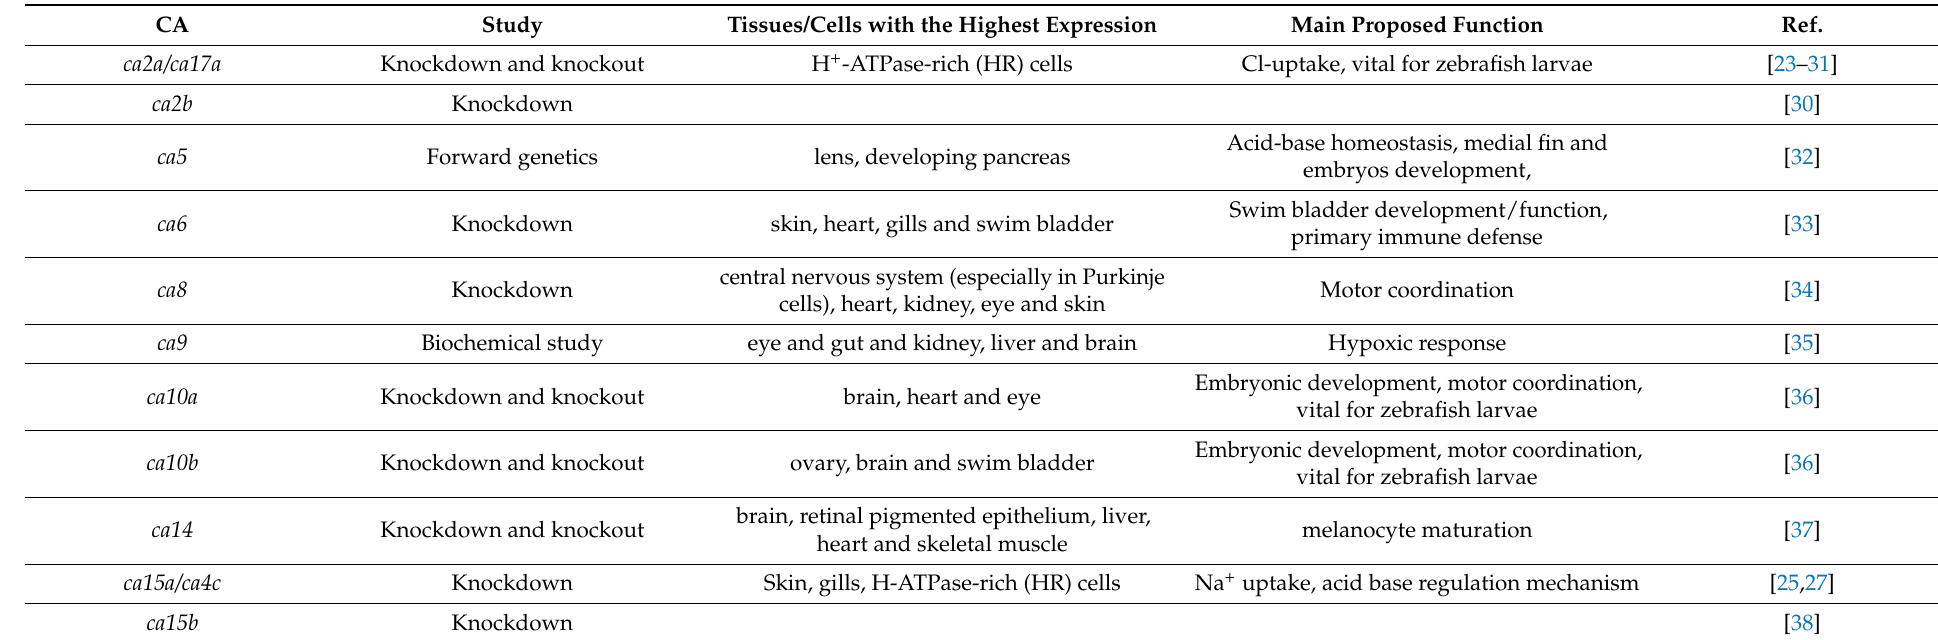
Table 1. The details of studies on zebrafish CAs and their proposed